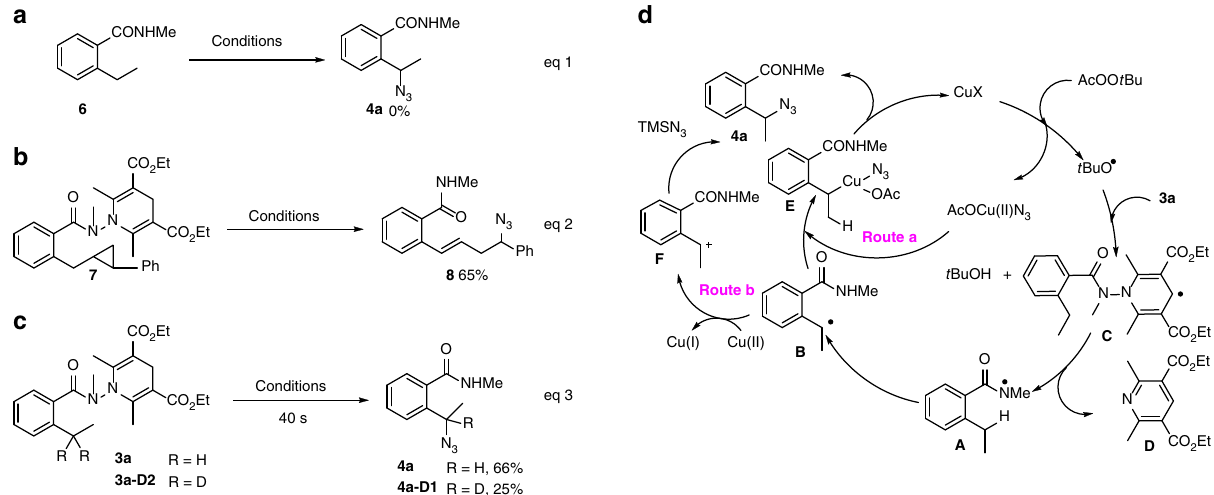
Fig. 3 Mechanistic studies on the γ -azidation of 2-alkyl benzohydrazides. a Control experiment; b radical clock experiment; c KIE experiment; d possible reaction pathway; conditions: 6 , 7 or 3a/3a-D2 (0.1 mmol), TMSN 3 (0.2 mmol), Cu(MeCN) 4 PF 6 (0.04 mmol), MeCO 2 O t Bu (0.2 mmol), t BuOH (2.0 mL, c 0.05 M), 50 °C, 2